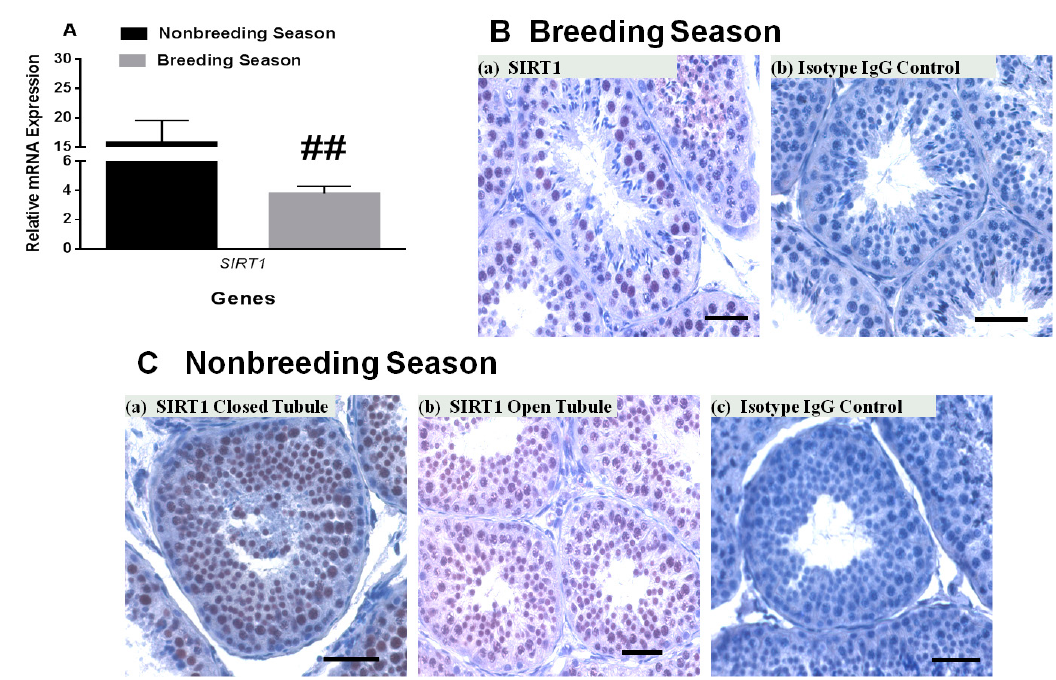
Figure 4. Comparison of SIRT1 / SIRT1 expression in breeding and nonbreeding seasons. ( A ) SIRT1 mRNA expression was significantly decreased during the breeding season as compared to nonbreeding season in testes of the adult rhesus monkeys testes ( n = 3–5 per season). ( B , C ) The number of SIRT1-positive germ cells was low in the breeding season ( B )a-b as compared to the nonbreeding season ( C )a–c. Scale bar, 50 µm.